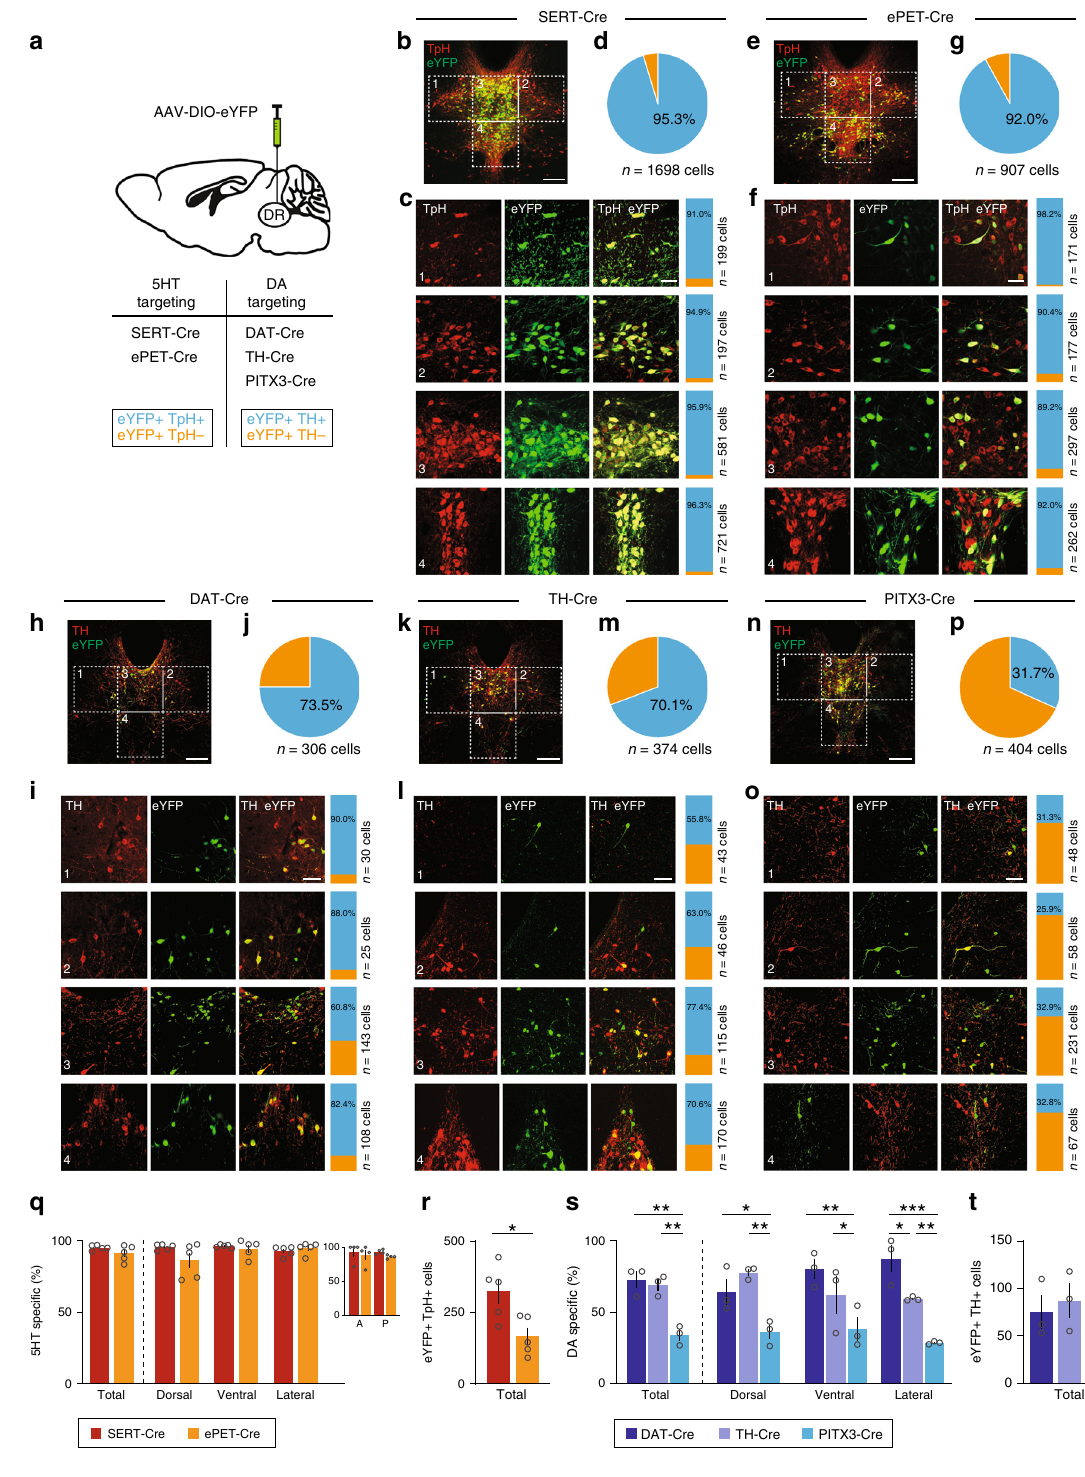
(Supplementary Fig. 1H, L). Immunohistochemical analysis revealed slightly lower selectivity for transgene expression in TpH − positive neurons compared to the DR for both lines (SERT-Cre: eYFP + /TpH + 85.8%, n = 641/747 cells from n = 3 mice; ePET-Cre: eYFP + /TpH + 78%, n = 160/205 cells from n = 3 mice), but again we observed much more ef fi cient viral labeling of TpH + neurons in SERT-Cre compared to ePET-Cre mice